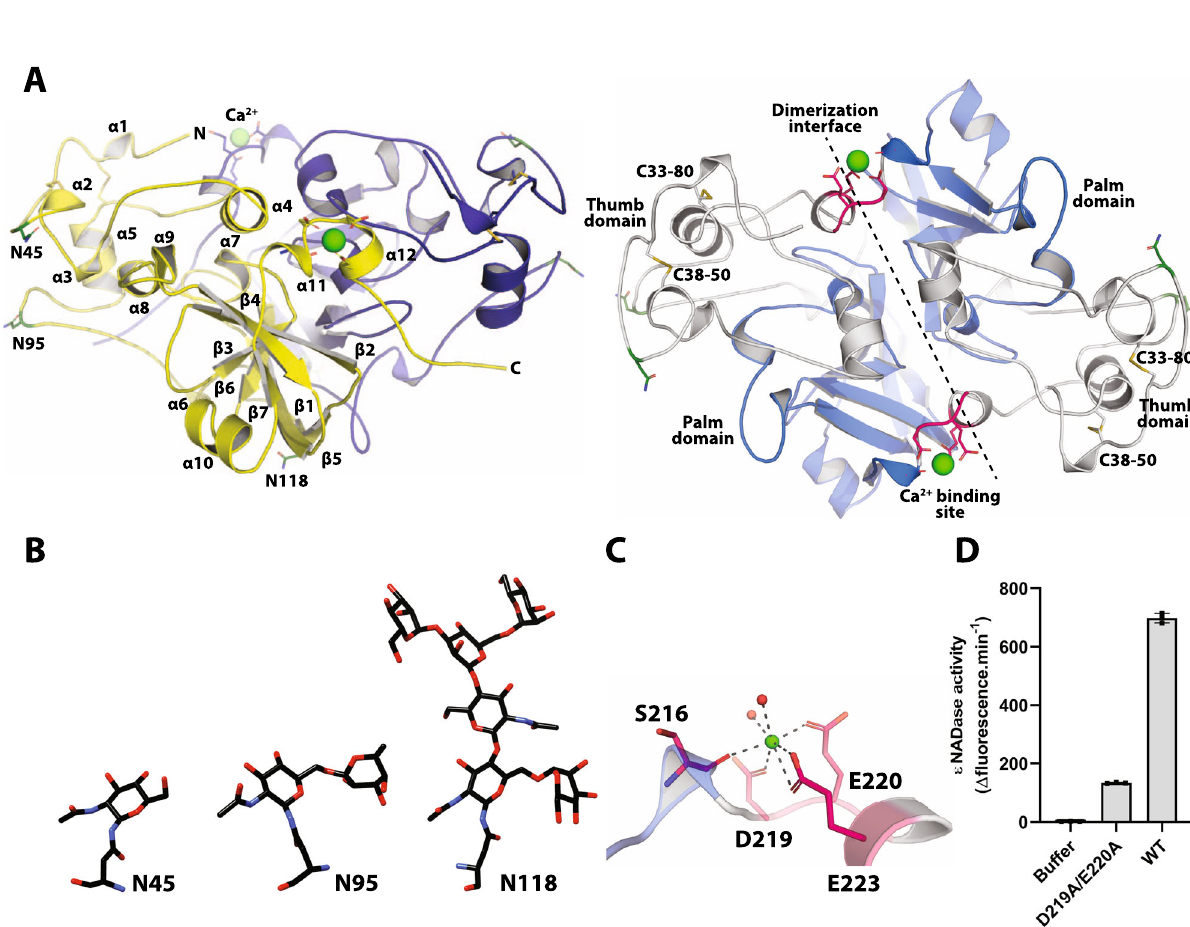
Fig. 2 Af NADase is a pure NAD(P) + glycohydrolase. A NADase activity of recombinant Af NADase puri fi ed from Sf9 insect cells measured by the fl uorescence assay using ɛ NAD, n = 3. B left: NADase activity of recombinant Af NADase from Sf9 insect cells treated with DTT, EGTA or EGTA and calcium chloride, n = 3 Right: NADase activity of Af NADase from Sf9 insect cells titrated with EGTA and CaCl 2 . C identi fi cation of Af NADase substrate speci fi city by HPLC. The HPLC chromatograms display Af NADase mediated reactions using the indicated substrates. D Kinetics of NAD + and NADP + hydrolysis by Af NADase determined by 1 H NMR. The integral of the resonances corresponding to NAD + N-2 and N-6 were plotted and used for curve fi tting. E Absence of ADP-ribosyl cyclase activity in Af NADase. In the presence of an excess of NA some NADases (namely ADP-ribosyl cyclases) can catalyse the exchange of the Nam moiety in NAD + for NA producing NAAD ( “ base-exchange reaction ” ). Cyclases can also produce cyclic ADPR or simply cleave NAD + to ADPR and Nam. F Af NADase does not possess base-exchange or ADPR cyclase activity, identifying it as pure NADase. HPLC chromatograms of Af NADase and Aplysia californica cyclase base exchange reactions. Experiments in ( A , B , C , F ) were performed independently three times with similar results. Source data are provided as a Source Data fi le.